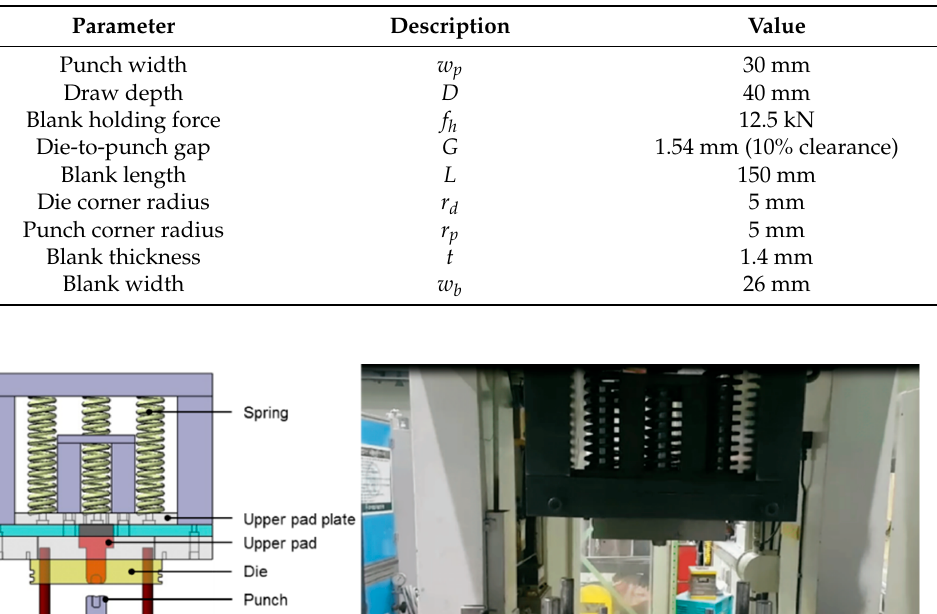
Table 6. Geometric and process variables for the drawing wear test [36].